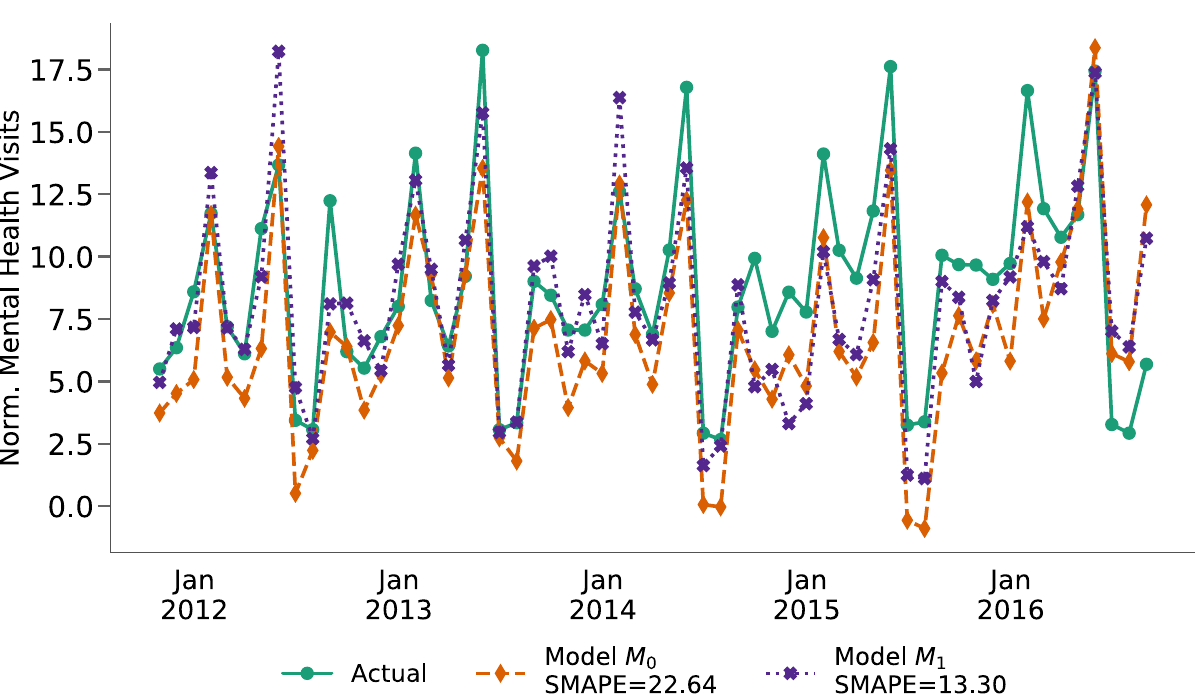
Figure 3. SARIMA models to predict the number of on-campus mental health consultations